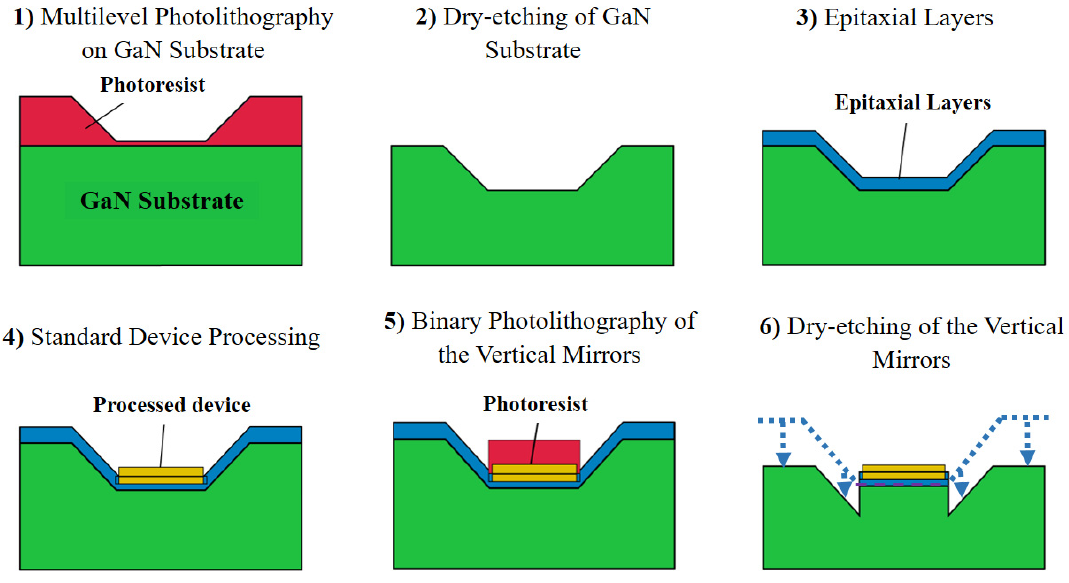
Figure 3. Scheme of consecutive device processing steps from GaN patterning to formation of vertical and deflecting mirrors.